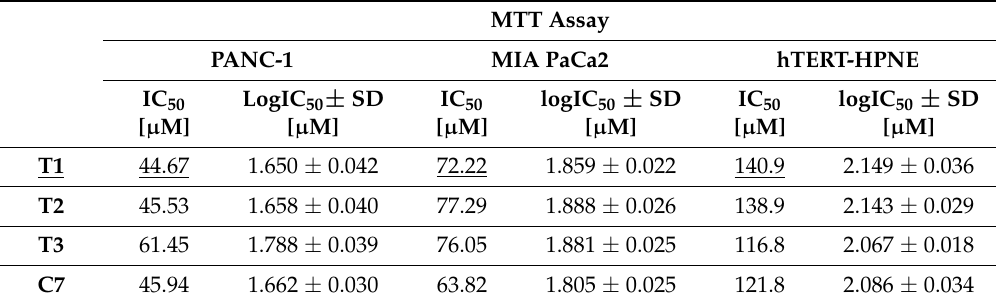
Figure 2. Cytotoxicity of vanadium complexes on pancreas ductal adenocarcinoma cell lines (PANC ‐ 1, MIA PaCa2) and immortalized pancreas duct cells (hTERT ‐ HPNE). Cytotoxicity was measured as cell viability using MTT ( A ) and NR ( B ) assays. Cells were exposed to four vanadium complexes (T1 ‐ T3 and C7 for comparison) at concentrations ranging from 1 to 100 μ M for 48 h. The marked results were shown the least cytotoxic effect on hTERT ‐ PHNE cell line. Data are mean ± SD of 3 separate determinations. * p < 0.05; ** p < 0.01; *** p < 0.001, as compared with untreated cells. Table 2. Cytotoxic activity of vanadium complexes on PANC ‐ 1, MIA PaCa2 and hTERT ‐ HPNE cell lines after 48 h of treatment. Data are expressed as IC 50 and logIC 50 (mean ± SD of 3 separate determinations) and were calculated on the basis of MTT and NR determinations.